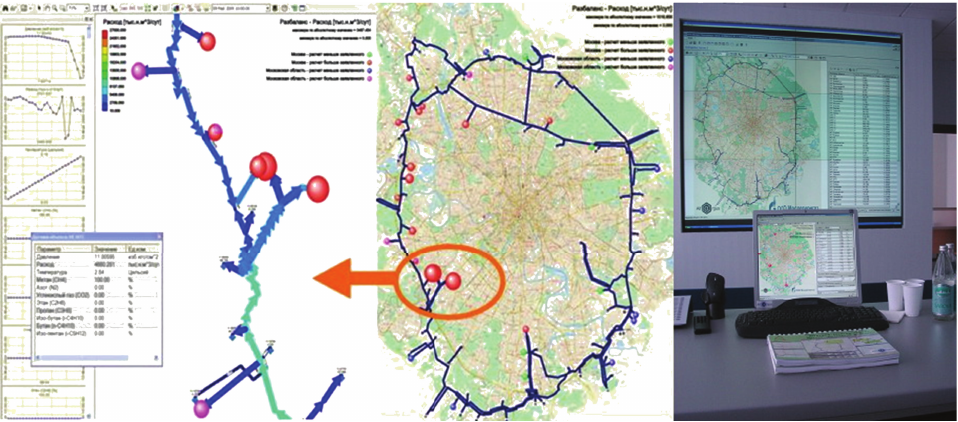
Figure 6: Numerical simulation of natural gas transmission along MRGDPS (cid:5) an example of CAS application in Mosregiongaz Control Room (cid:6)